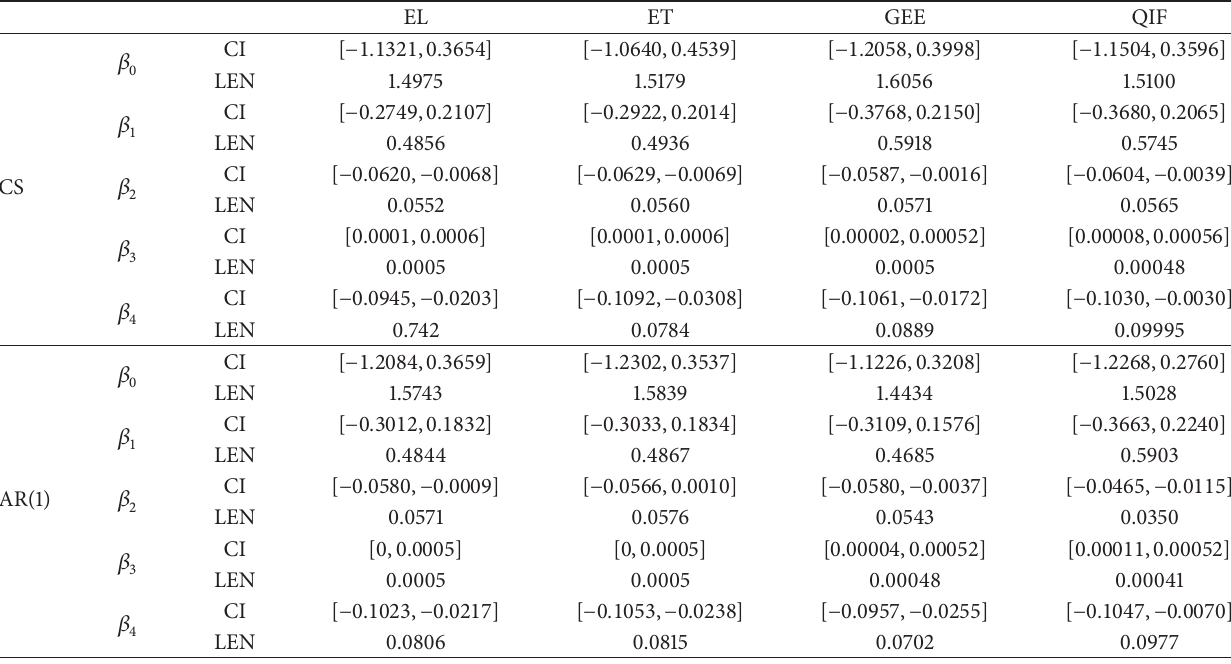
Table 3: 95% confidence intervals (CI) and the lengths (LEN) of the confidence intervals for CS and AR(1) correlation structures.